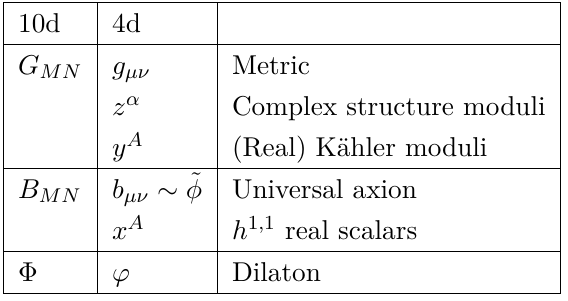
Table 8 . Massless fields in type-II Calabi-Yau compactifications, NS-NS sector.